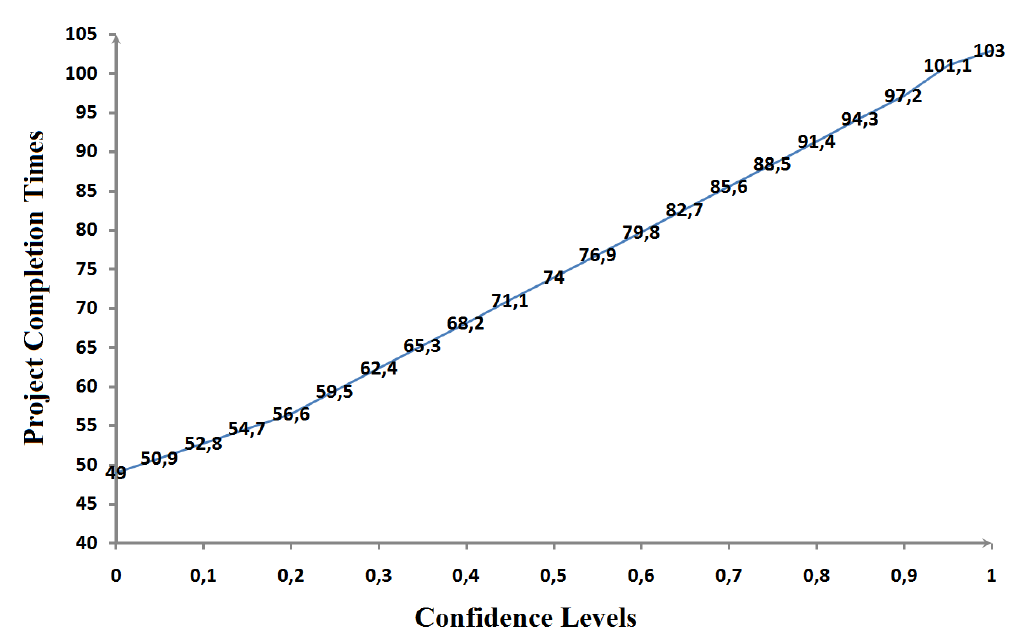
Figure 3. The relationship between completion times and confidence